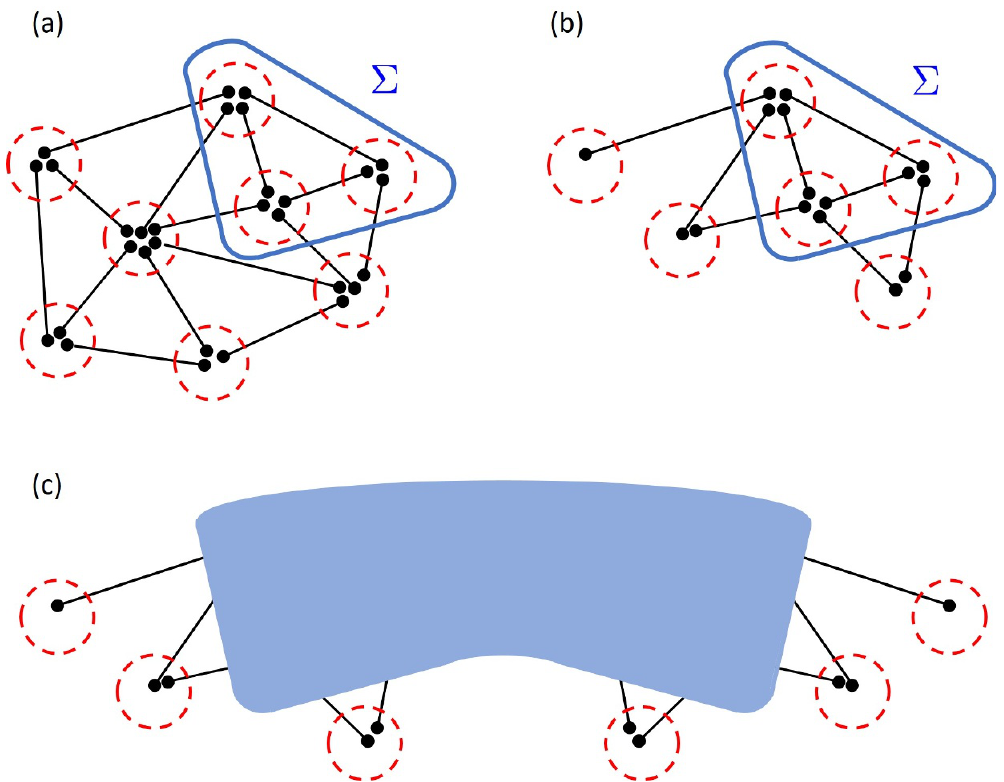
Figure 12 . (a) The link state j L i is depicted. The region (cid:6) is outlined in blue, and in this case contains 3 vertices and 11 qudits. (b) The state j L (cid:6) $ (cid:6) i (cid:10) j L i is shown. The EPR pairs lying (cid:6) $ (cid:6) within (cid:6) form j L (cid:6) $ (cid:6) i , and the EPR pairs crossing the boundary of (cid:6) form j L i . The qudits (cid:6) $ (cid:6) lying outside of (cid:6) form the Hilbert space H @ (cid:6) . (c) By taking two copies of j L (cid:6) $ (cid:6) i (cid:10) j L i (cid:6) $ (cid:6) and partially contracting their (cid:6) regions with the state (cid:26) (cid:6) , we obtain the density matrix (cid:27) @ (cid:6) , P which is depicted in the (cid:12)gure. The light blue region represents the contraction of the (cid:6) regions of j L (cid:6) $ (cid:6) i (cid:10) j L i and h L (cid:6) $ (cid:6) j (cid:10) h L j with (cid:26) (cid:6) . We see that the density matrix (cid:27) @ (cid:6) maps P (cid:6) $ (cid:6) (cid:6) $ (cid:6) H (cid:3) (cid:10) H @ (cid:6) ! C , since a state on H @ (cid:6) can be contracted with the exposed legs on the right-hand @ (cid:6) side, and a dual state on H @ (cid:6) can be contracted with the exposed legs on the left-hand side. But since (cid:27) @ (cid:6) = 1 R (cid:10) (cid:26) we have U (cid:27) @ (cid:6) U y = (cid:27) @ (cid:6) and so the U dependence drops out R R R R d R of the above equation.